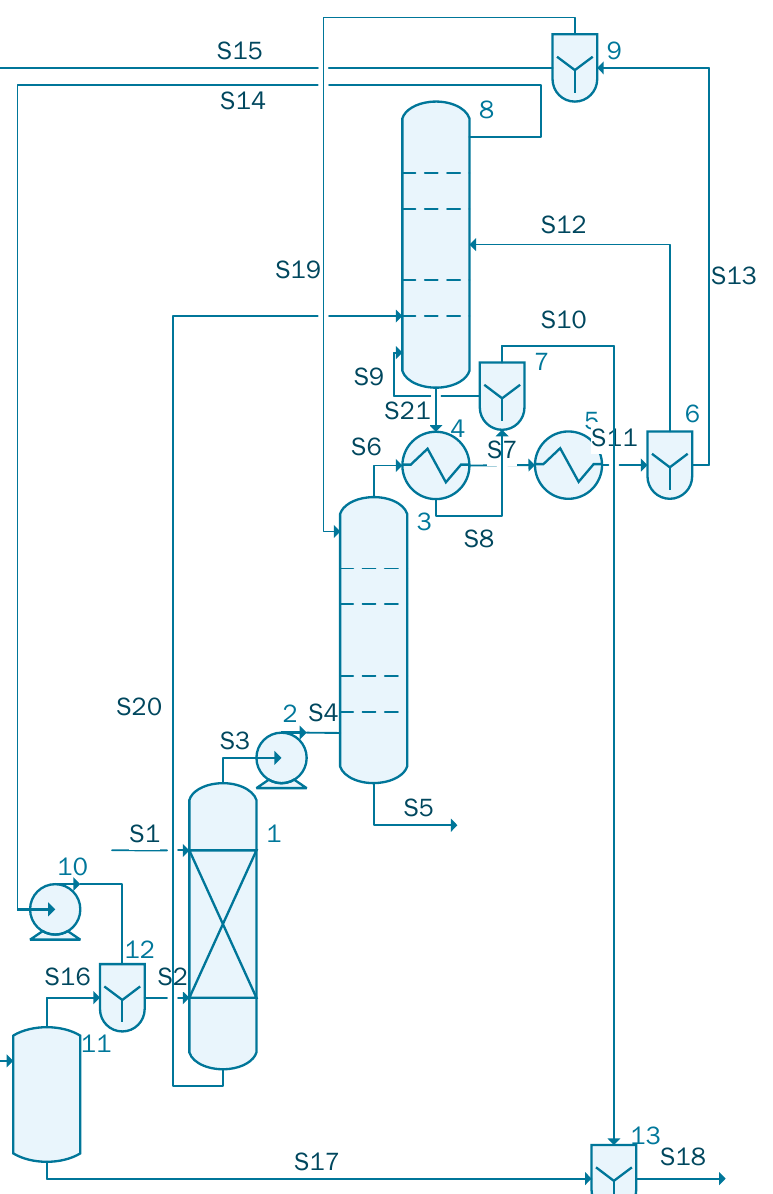
Figure 6. Process flow diagram of the acetic acid concentration process with DED (case 5).